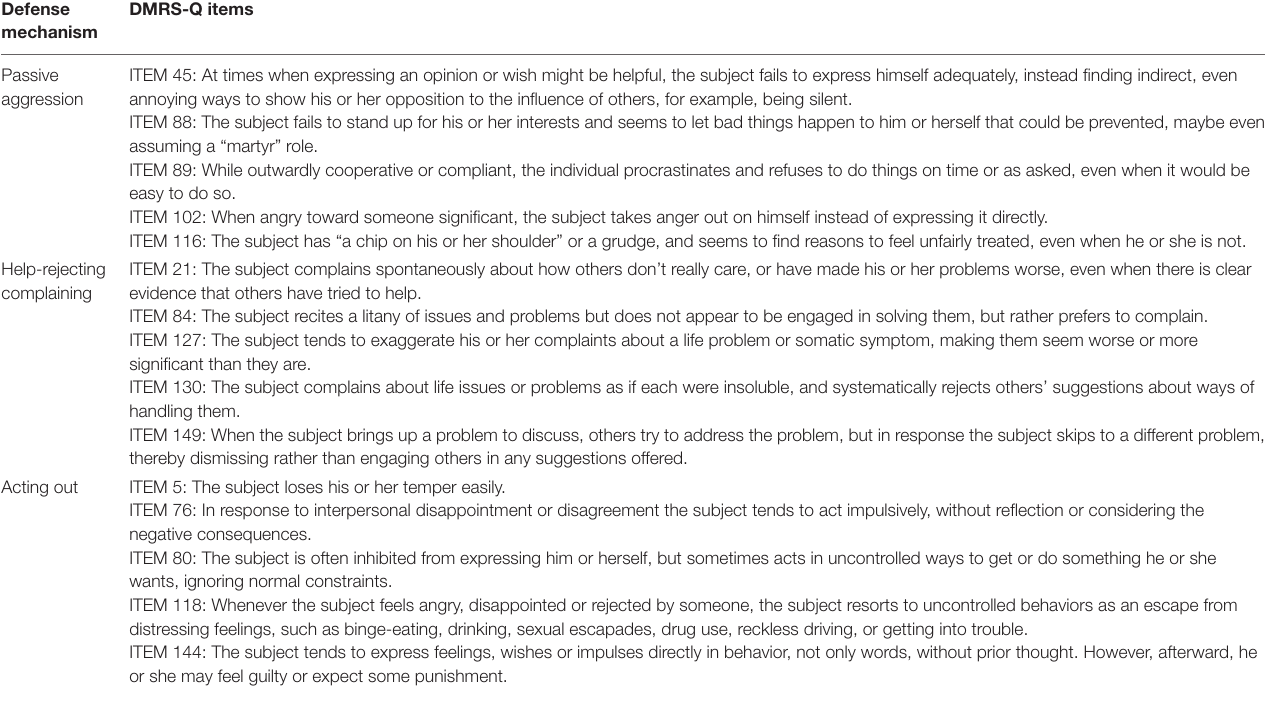
TABLE 8 | Action defense level: Definition, function and DMRS-Q items of defenses acting out, help-rejecting complaining, and passive aggression. Defense